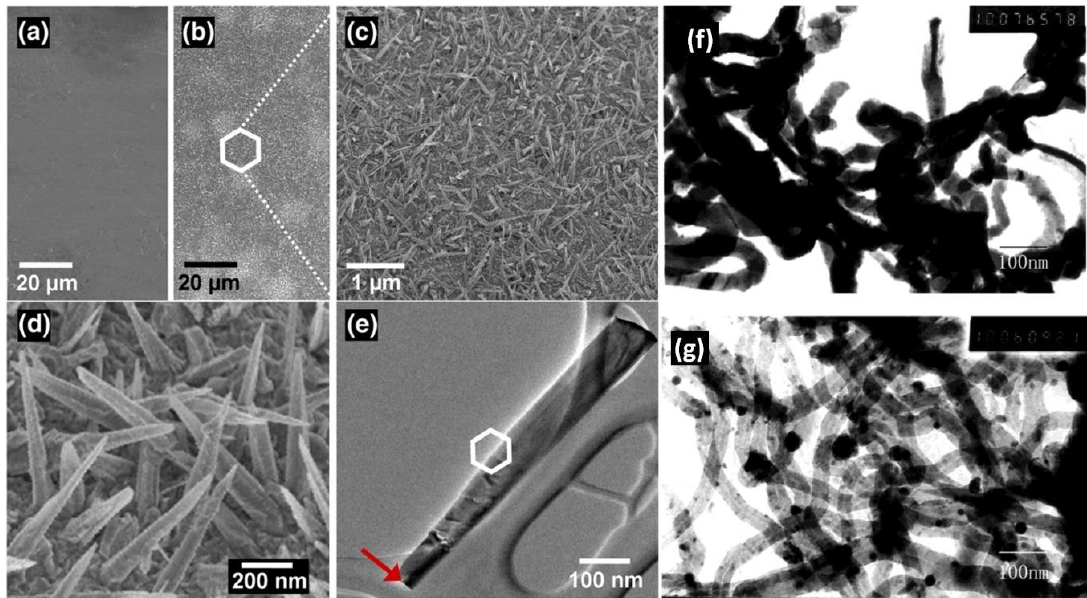
Figure 65. ( a – e ) SEM images of the surface of the Zn sheet: ( a ) Low-magnified image before the microwave irradiation. ( b ) Low-magnified image after the microwave irradiation. ( c ) Medium- magnified image after the microwave irradiation. ( d ) High-magnified image after the microwave irradiation; ( e ) TEM image of a ZnO nanoneedle. Products synthesised by direct microwave irradiation on the Zn sheet under O 2 and Ar atmosphere (total pressure: 1 atm). Reprinted from [886], Copyright (2008), with permission from Elsevier [OR APPLICABLE SOCIETY COPYRIGHT OWNER]. All rights reserved. In order to re-use permission must be obtained from the rightsholder. ( f – g ) TEM images of ( f ) Zn-ZnO nanocables and ( g ) ZnO nanotubes. Reprinted (adapted) with permission from [899]. Products synthesised by microwave vapour deposition. Copyright © 2003,